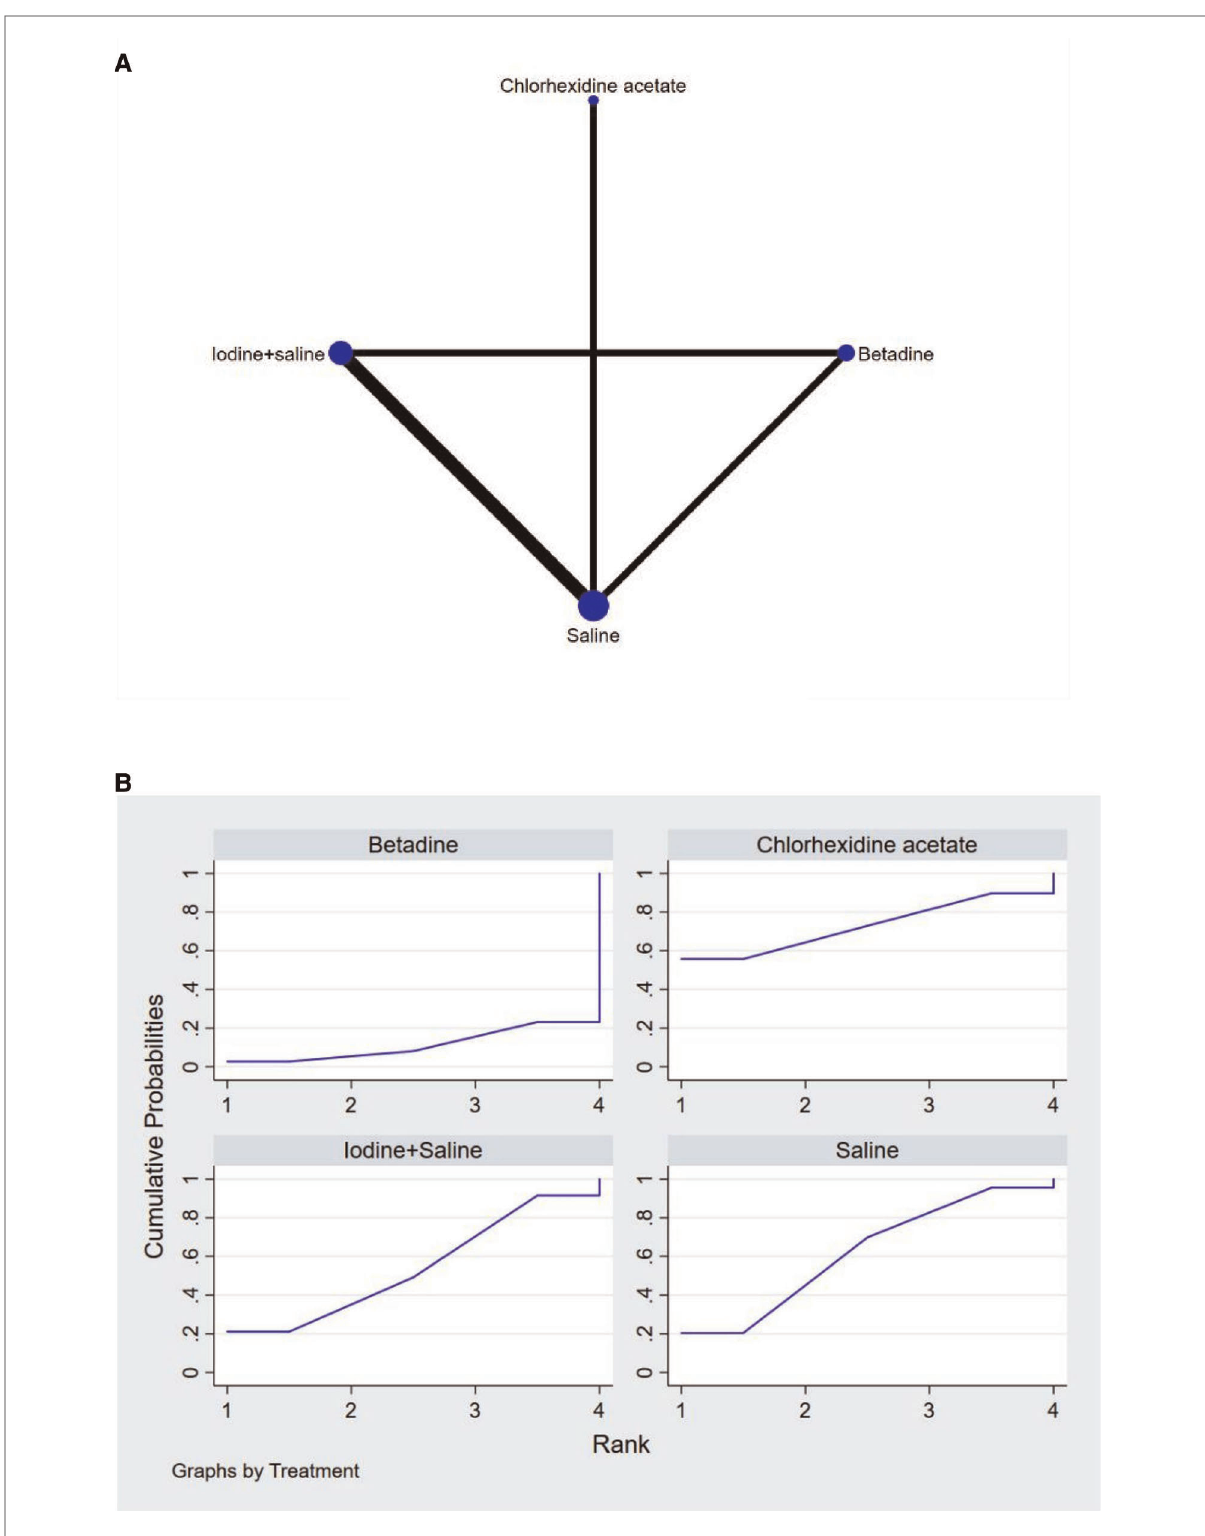
FIGURE 5 ( A ) NMA fi gure for CP ( B ) SUCRA plot for